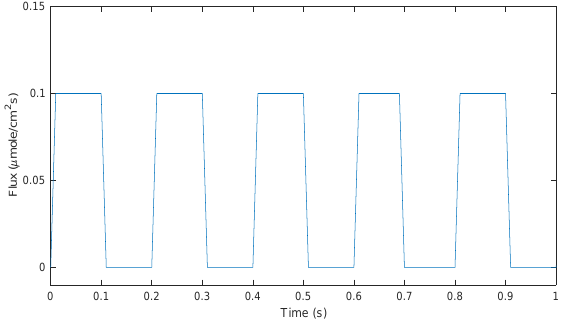
Figure 11. 5 Hz pulses applied to the surface of the particle.